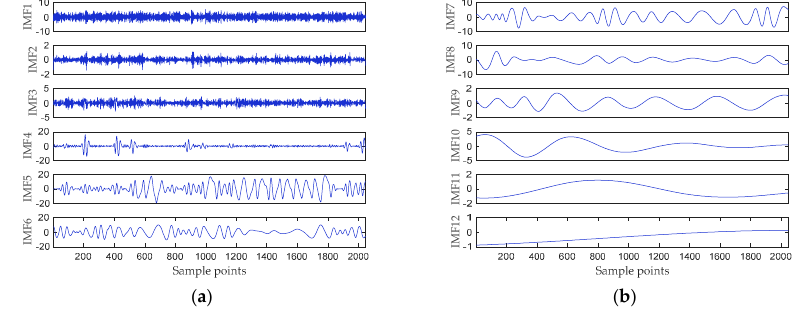
Figure 6. The noisy signal and the noiseless signal.